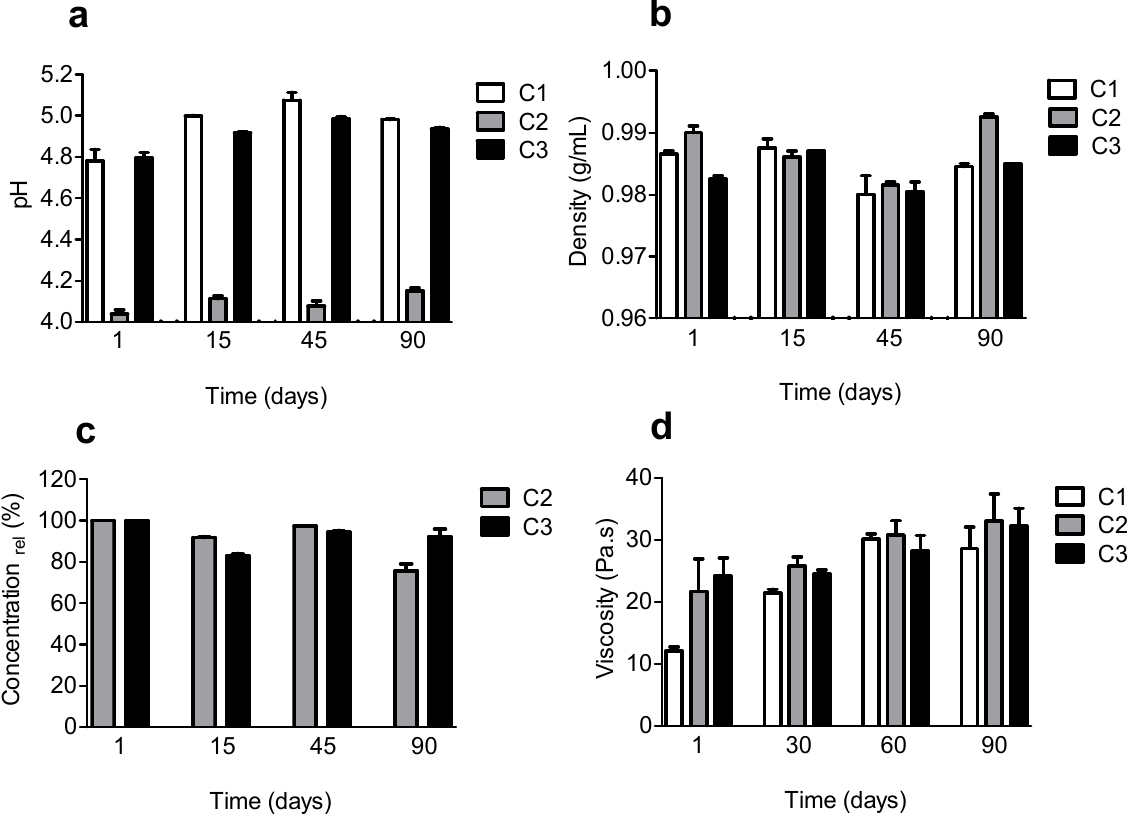
Figure 6. Stability of the creams. The creams were stored in transparent PVC packages at room temperature. After daylight exposure for up to 90 days ( a ) pH, ( b ) density, ( c ) concentration and ( d ) viscosity of the creams were evaluated. C1 (base cream), C2 (base cream plus FA) and C3 (base cream plus FAEE). The results are mean and SD of triplicates.